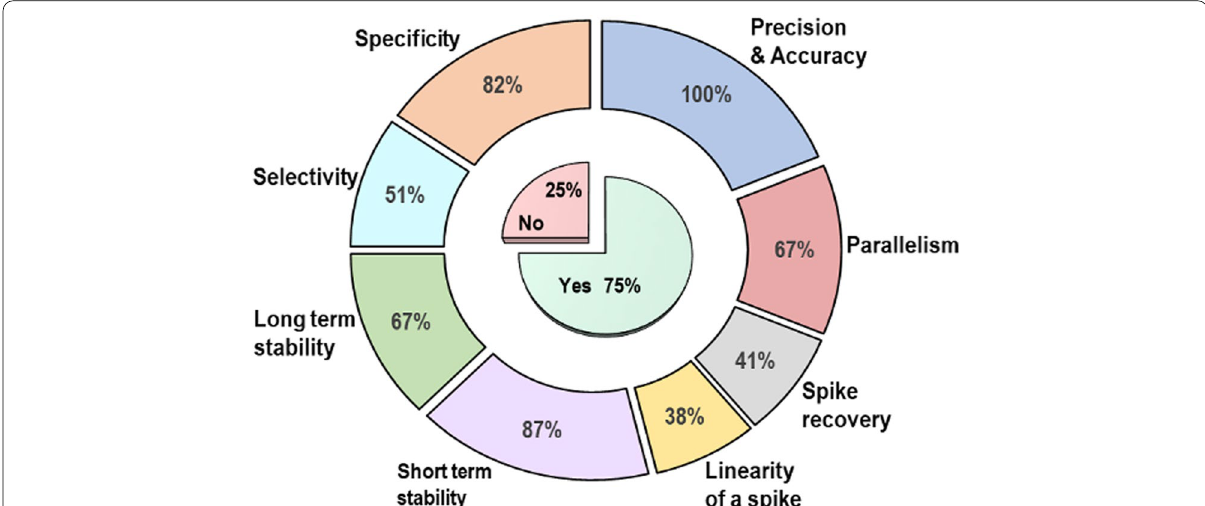
Fig. 2 Pre‑workshop survey—key criteria for validation method. A large majority of the 41 survey respondents (75%) pronounced in favor of establishing a minimal requirement for method validation (center graph). The respondents also indicated the key validation criteria which should be included in a method validation (outer ring, shown as the percentage of total respondents). Of note, for protein biomarker assay (ligand binding and mass spectrometry), accuracy is often referred to as relative accuracy given that calibrators composed of recombinant protein are not typically identical to the endogenous biomarker, thus the concentration is relative to the specific assay used. However, the survey did not highlight this point. For cellular biomarkers, accuracy is even more challenging due to the lack of appropriate cellular reference materials for multiparametric flow cytometry